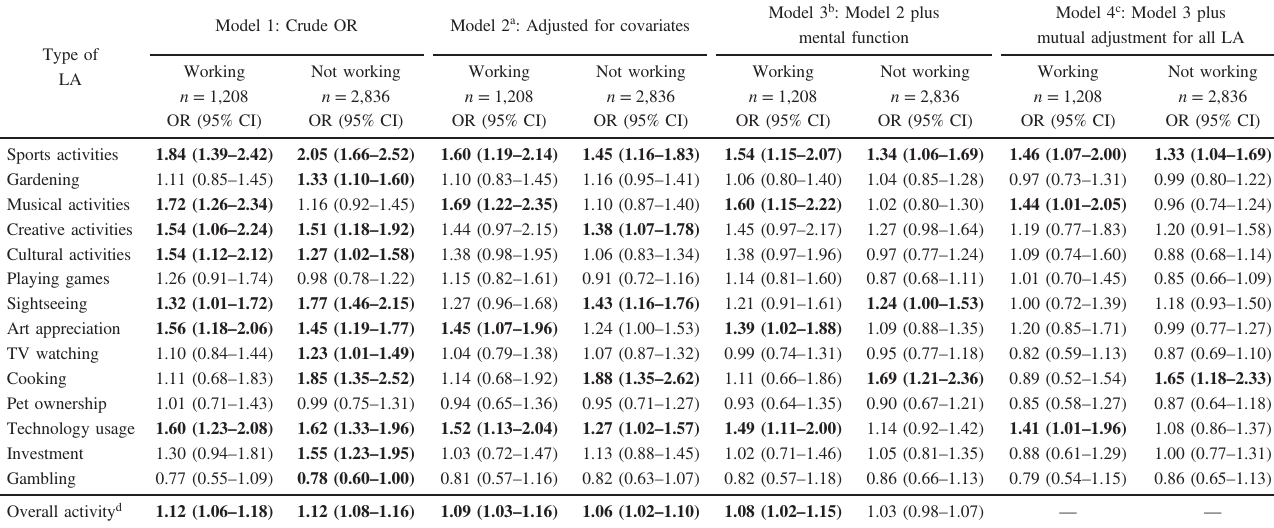
Table 3. Crude and adjusted odds ratios for positive self-rated health associated with the type of leisure activities by work status in 4,044